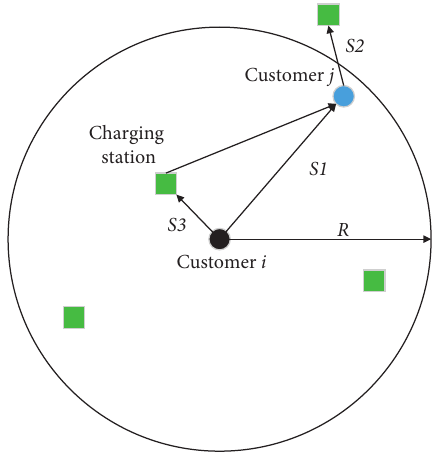
Figure 2: Schematic diagram of